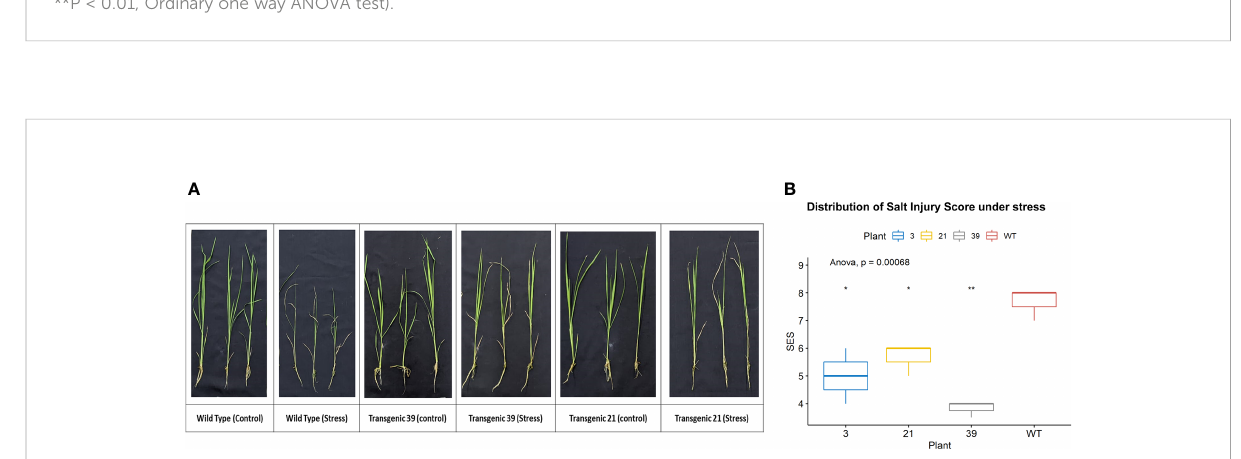
FIGURE 10 (A) The transgenic plants (line 39 and line 21) showed healthy appearance under 120 mM salt stress compared to the wild type plants. (B) Transgenic Line 39 showed signi fi cant (P<0.01) low SES score (high tolerance) than the WT. **P < 0.01, *P <